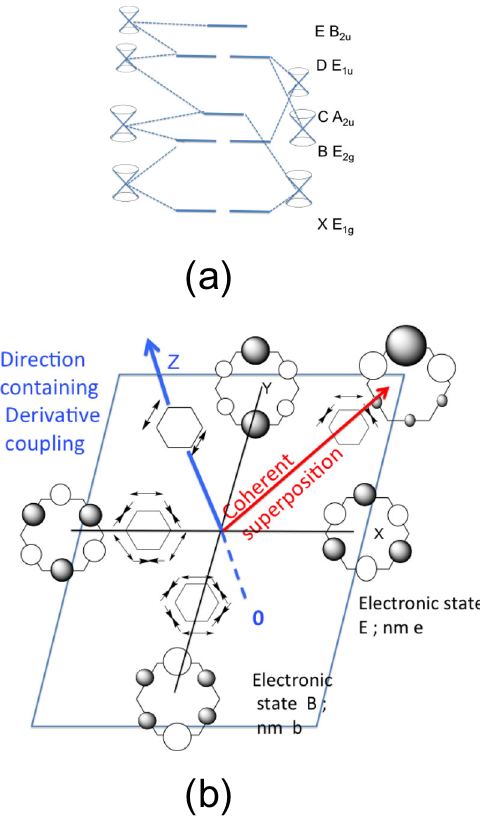
Fig. 1 Comparison of non-adiabatic dynamics mechanisms. a From successive decay through conical intersections E → D → B → etc. versus b from a coherent superposition of two nonadjacent electronic states E and B. In b , the electronic states are represented with open (negative) and shaded circles (positive) representing the lobes on the electron density in the hole state MO. The normal mode stretches are represented with arrows. A more detailed discussion of the representation of the electronic states will be given subsequently. The Z-axis represents the interstate gradient as a combination of C – C stretches. At 0 on the Z-axis, there are no components of the gradient that do not belong to non-totally symmetric representations. As one moves along the Z-axis, one breaks symmetry and nonsymmetric gradients that develop in the XY plane, and one sees electron and nuclear dynamics along the red